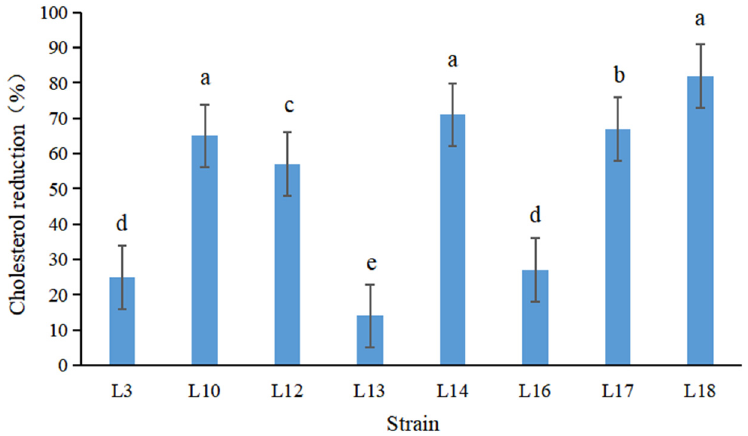
Figure 1. The cholesterol reduction (%) of selected 8 strains. The different letters indicated sig- nificant difference among treatments ( p < 0.05). difference among treatments ( p <